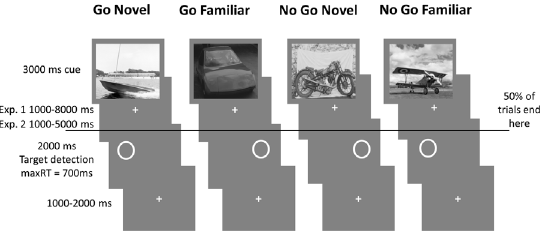
Fig 1. Experimental paradigm. Subjects were presented with 80 trials in each of four consecutive blocks. In each trial, an image from one of four categories (randomized across subjects) informed subjects about whether to press when a circle was displayed or to not respond (Go/No Go). In two conditions images were trial unique (Novel) and in two conditions four images within the category were repeated (Familiar). Subjects were pre-exposed to Familiar images during training. The cue was followed by a fixation period of varying length (1000 – 8000 ms in Experiment 1 and 1000 – 5000 ms in Experiment 2). Then, in 50% of the trials a circle was presented either on the left or the right instructing subjects to respond by pressing the left or right arrow key. This was followed by another fixation of variable length (1000 – 2000